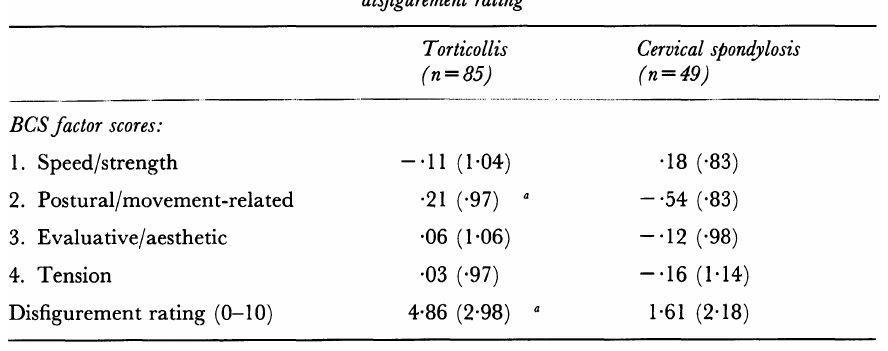
TABLE I. Mean and standard deviation scores (in parentheses) of the torticollis patients and the cervical spondylosis group on the four factor scores derived from the Body Concept Scale (BCS) and